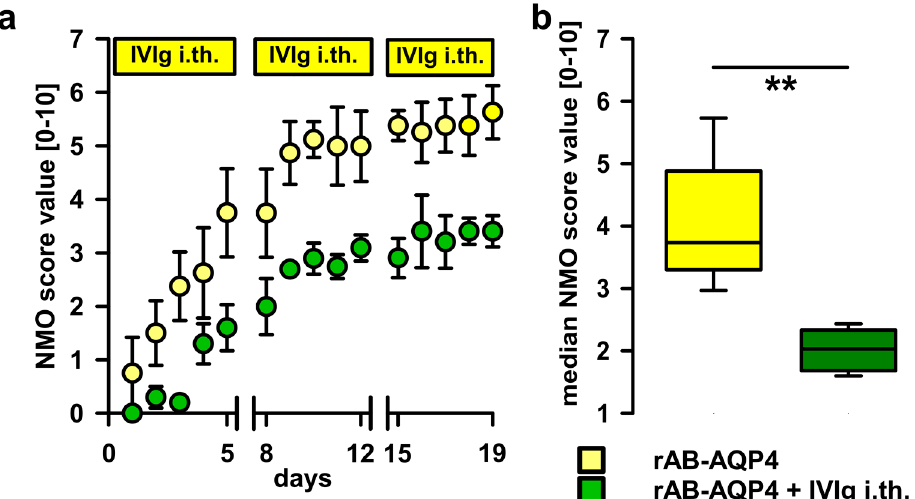
Figure 4. Effects of i.th. IVIg on disease progression induced by recombinant human anti-AQP4-ABs (rAB-AQP4). ( a ) i.th. rAB-AQP4 led to the development of moderate to severe disease signs (yellow circles) comparable to induction of disease using NMO-IgG. The signs of disease appeared later and the disease severity was reduced by concurrent i.th. injection of IVIg (Two-way ANOVA with Bonferroni post hoc test p < 0.001 for group comparison). Breaks on the X-axis indicate 2 day-pauses of NMO-IgG injections; ( b ) the treatment with i.th. IVIg over the entire experimental period led to a significant reduction of median NMO-Score (Mann-Whitney U test, ** p ≤ 0.01; plots show median ± 25th and 75th percentiles with whiskers of the 5th and 95th percentiles).